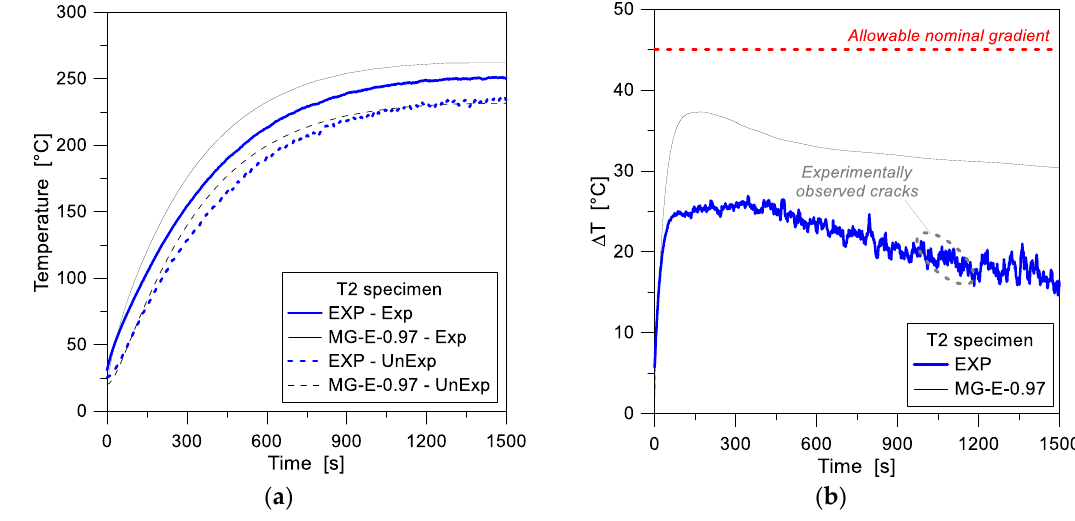
Figure 11. ( a ) Temperature history and ( b ) gradient comparisons for the MG specimen T2, as obtained from the FE analyses (ABAQUS, 1D), and the past experimental test.